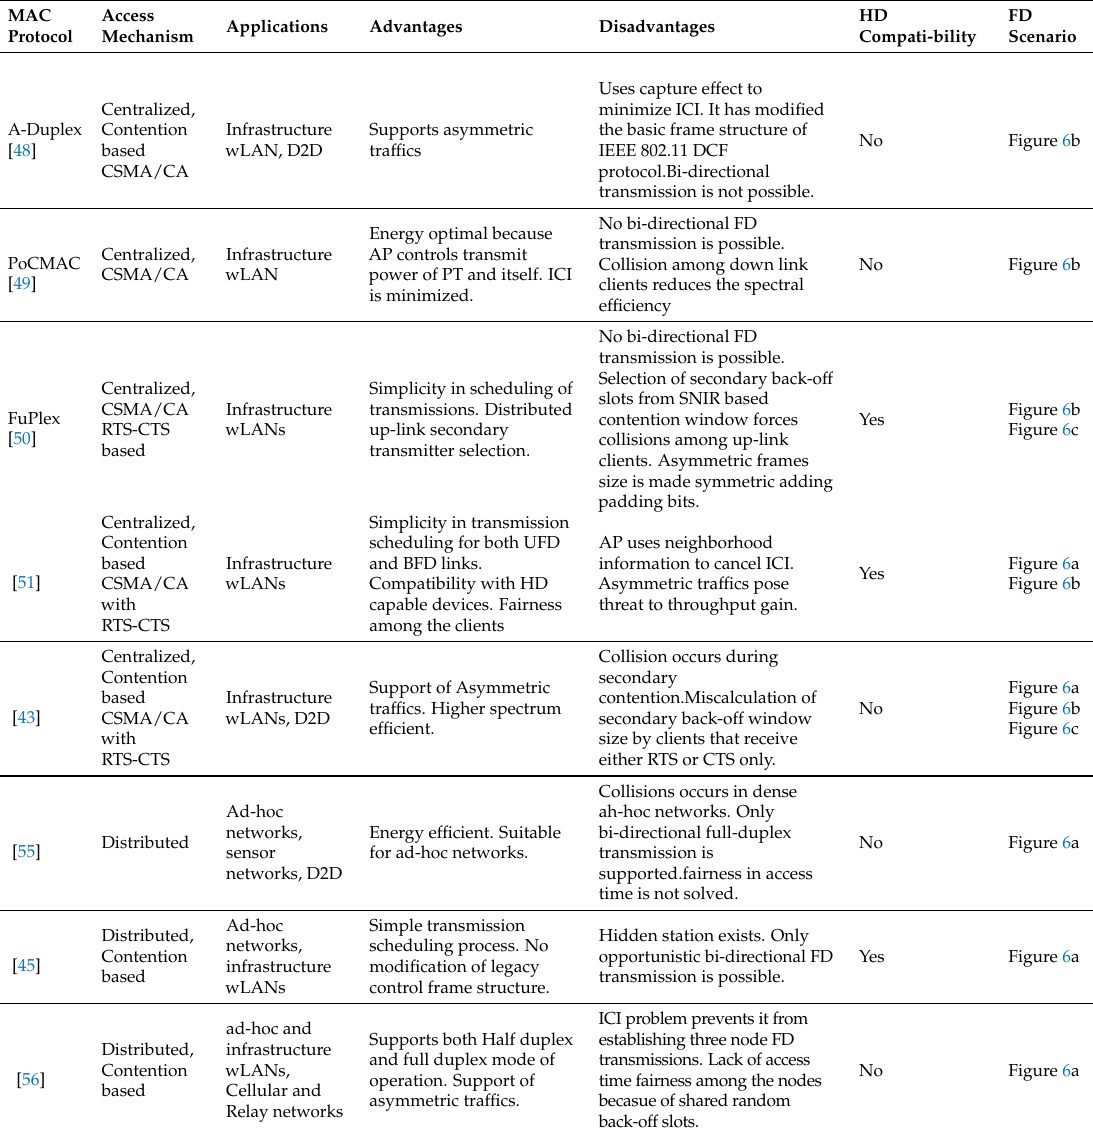
Table 4. Qualitative comparison of existing full duplex (FD) MAC protocols